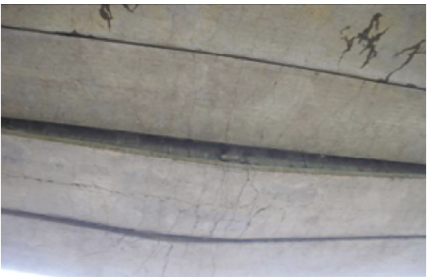
Figure 2: Permanent deformation of box girder after